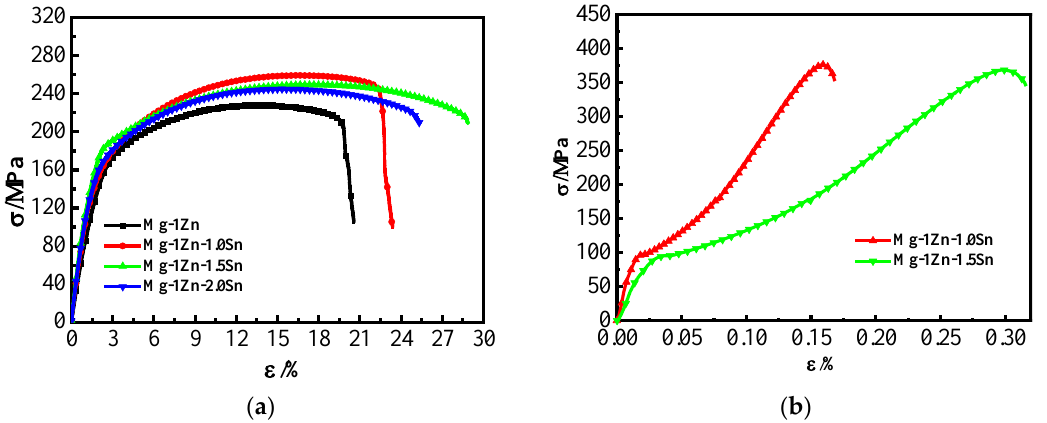
Figure 3. Mechanical properties of Mg-1Zn-xSn ternary alloys: tensile curves ( a ), compressive curves ( b ). Table 2. The mechanical properties of Mg-Zn-Sn alloys, bone, and AZ31 extruded alloys.